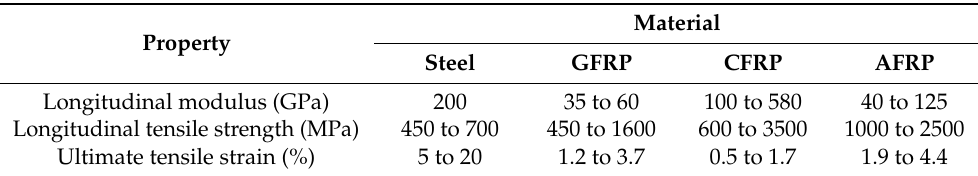
Table 3. Comparion of tensile properties of steel and FRP rebars (with volume fraction of fibre from 50 to 75%)